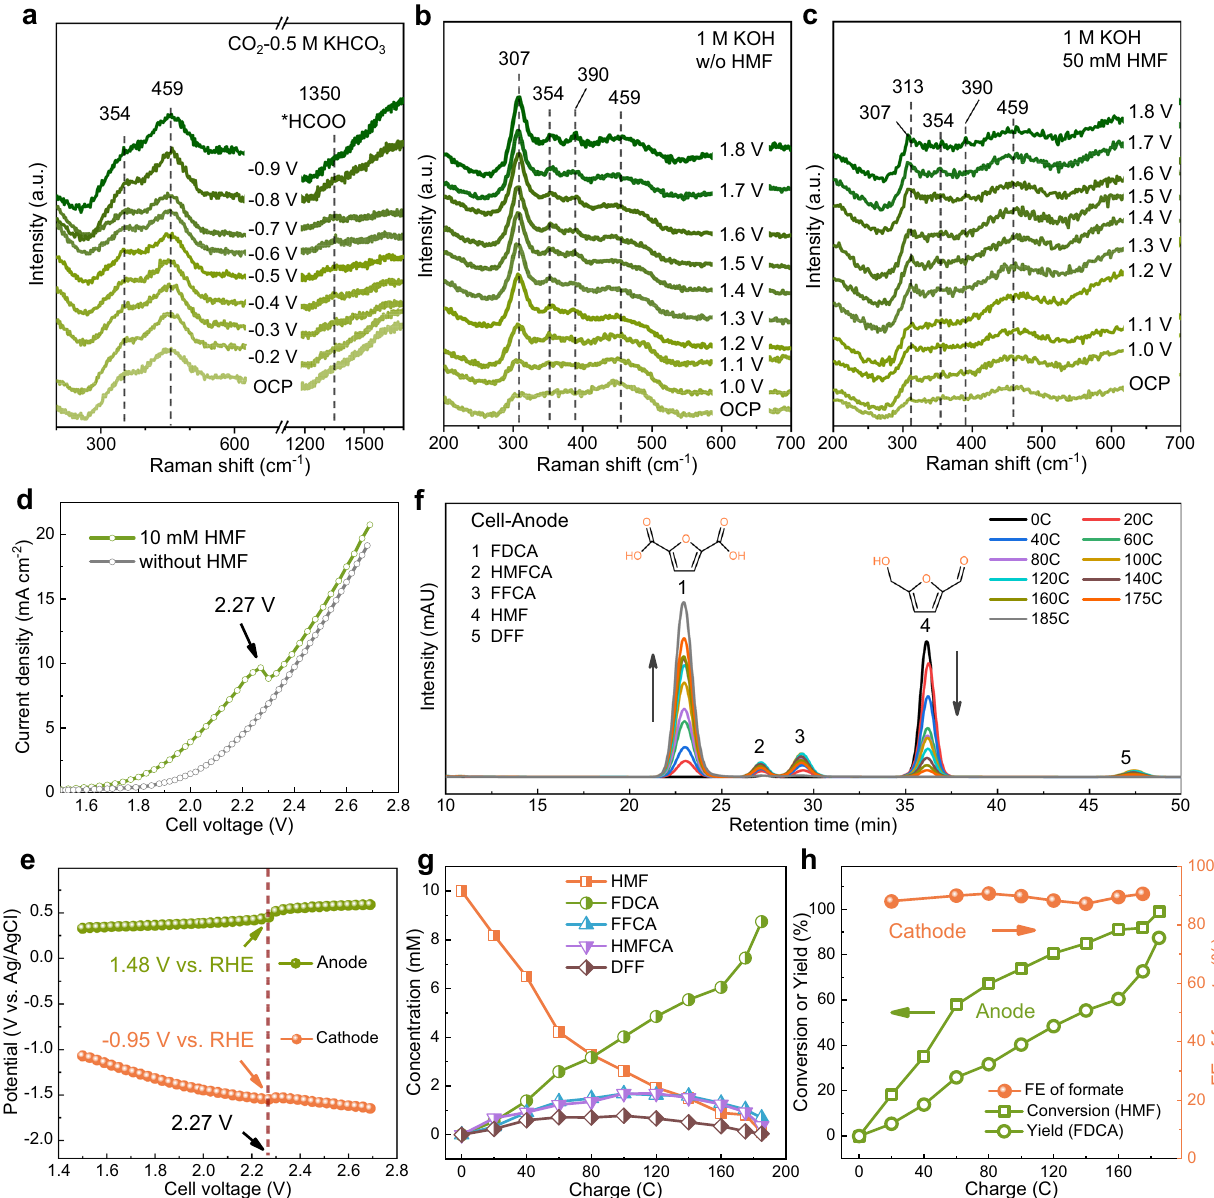
Fig. 6 | Operando Raman spectra and electrochemical performances for inte- grated cell. The operando Raman spectra of InOOH-O V in the electrolyte of a CO 2 saturated 0.5M KHCO 3 , b 1M KOH, and c 1M KOH with 50mM HMF. d The LSV curves of the integrated cell in the electrolytes with and without HMF. e The bias